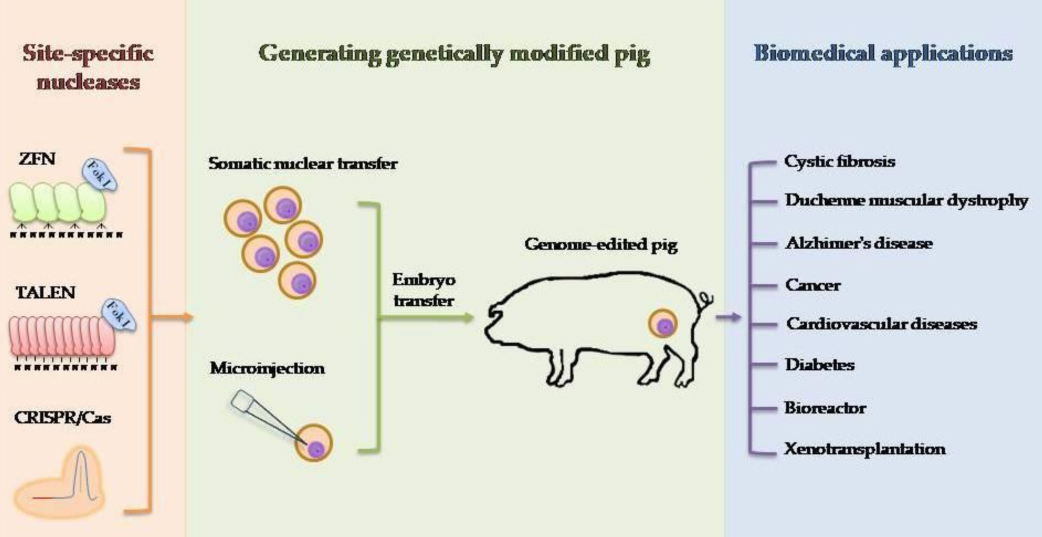
Figure 1. Schematic diagram of generation genetically engineered pig for biomedical purposes. The di ff erent site-specific nucleases (ZFN, TALEN, CRISPR / Cas9) used for genome editing and two techniques (somatic nuclear transfer and microinjection) to produce genetically modified pigs are shown. Biomedical applications for which genetically engineered pigs are generated include modeling human diseases, production of pharmaceutical proteins, and